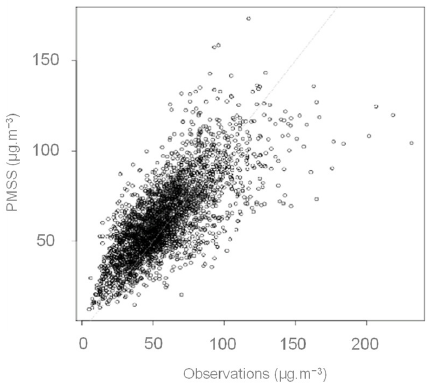
Figure 3. Scatter plot observation versus model for all the measurements points (two stations and five micro-sensors)—Hourly average concentration of NO 2 during the period from the 15 January 2017 to the 31 January 2017. Table 3. Statistics of comparison between observed and computed hourly average concentration of NO 2 during the period from the 15 January 2017 to the 31 January